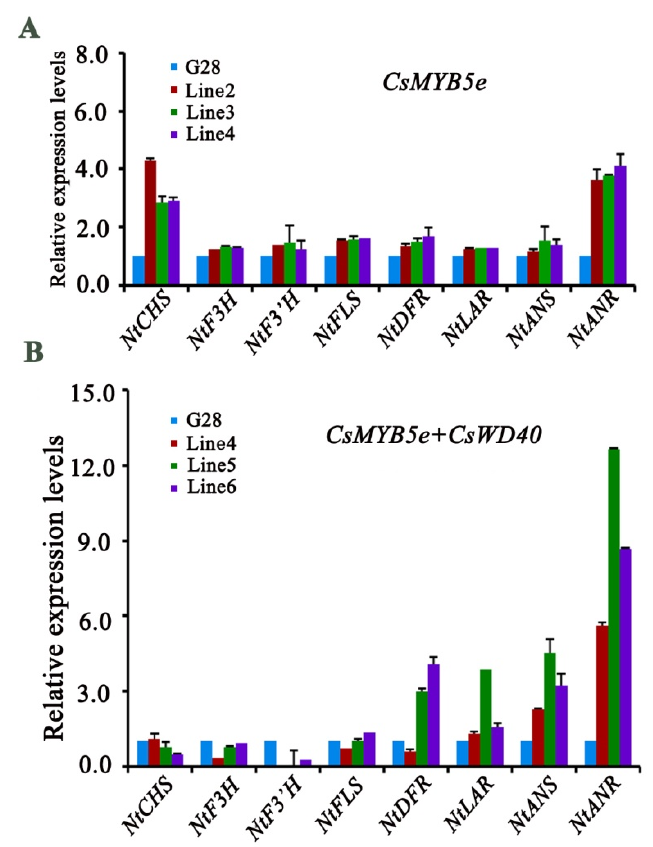
Figure 6. ( A ) Relative expression of flavonoid biosynthetic pathway genes in CsMYB5e overexpression tobacco petals. ( B ) Relative expression of flavonoid biosynthetic pathway genes in CsWD40 and CsMYB5e overexpressing tobacco petals. CHS, chalcone synthase; F3H, flavanone 3-hydroxylase; F3′H, flavonoid 3-hydroxylase; DFR, dihydroflavonol reductase; ANS, anthocyanidin synthase; ANR, anthocyanidin reductase; FLS, flavonol synthase.